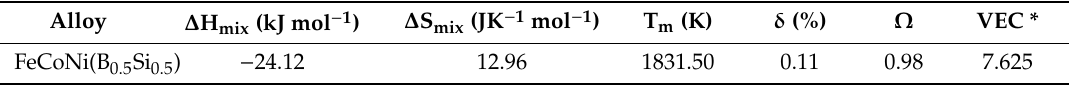
Table 3. Calculated parameters for FeCoNiB 0.5 Si 0.5 high-entropy alloy (HEA).